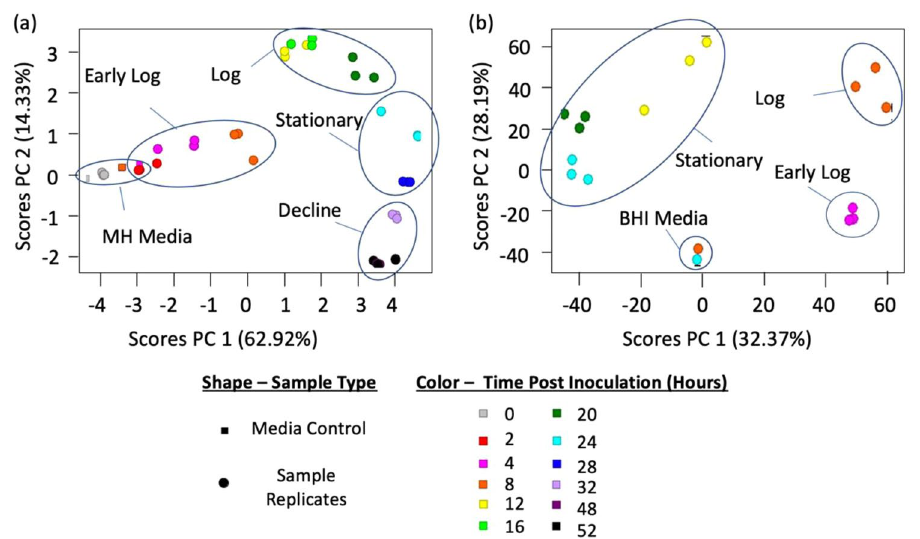
Figure 5. PCA scores plots for VOC marker profiles of ( a ) F. tularensis novicida and ( b ) B. anthracis Sterne generated using the peak areas of pathogen biomarkers across all timepoints. Each plot point represents one sample. Distinct chemical profiles were observed amongst labeled growth phases. Corresponding loadings plots to explain placement of samples are located in Supplemental Fig.